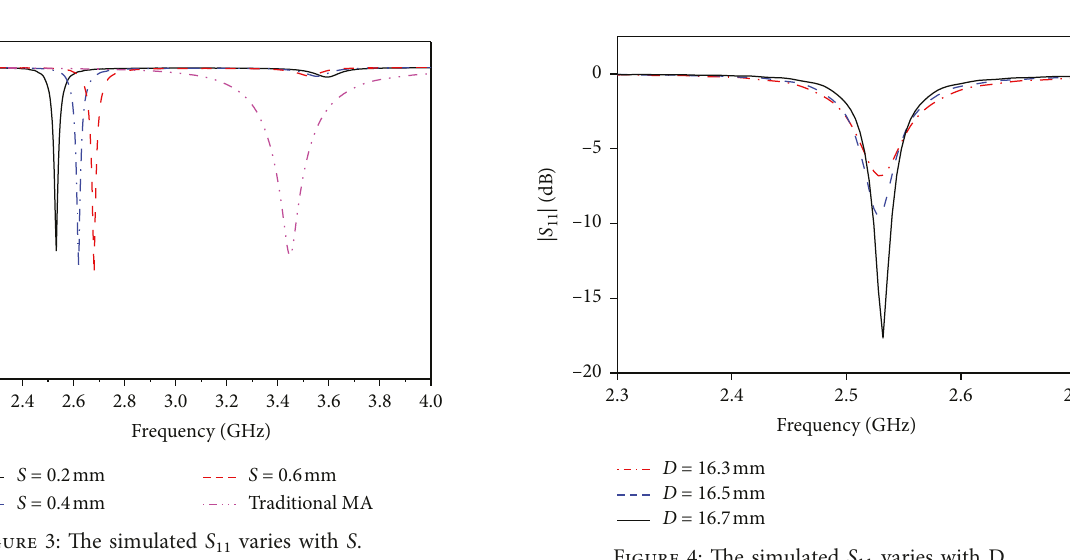
Figure 2: Equivalent circuit of the proposed compact MA.